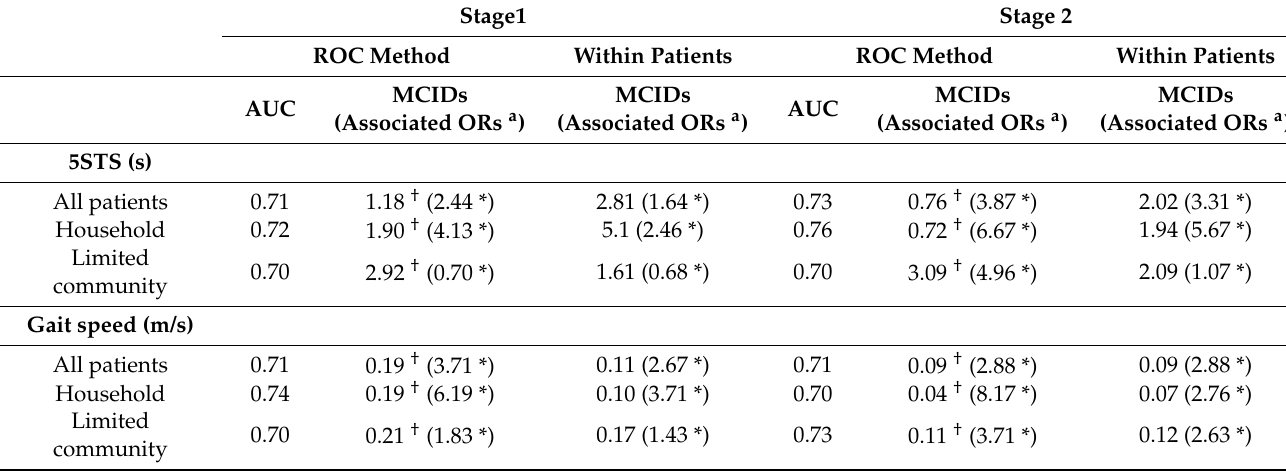
Table 3. The minimum clinically important difference (MCIDs) for the performance measures using the global rating of change scale by stage.